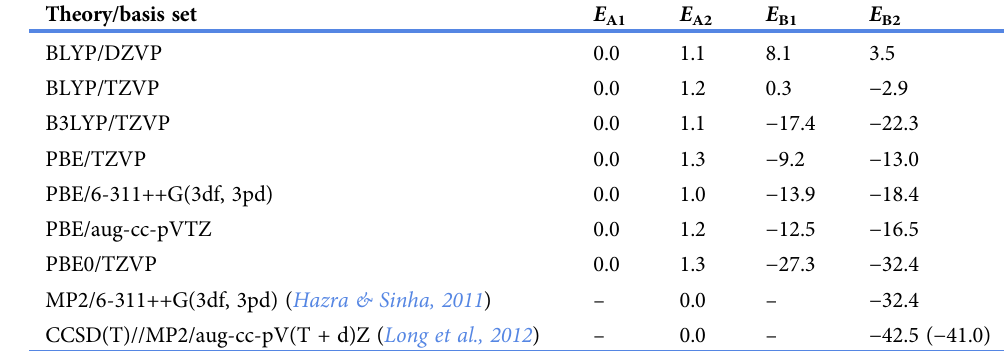
Table 1 Energetics of optimised reactant (A1 and A2) and product (B1 and B2) states using several different combinations of DFT functionals and basis sets. We also compare with high-level ab initio results already available in the literature ( Hazra & Sinha, 2011 ; Long et al., 2012 ). We note that the 6-311++G(3df, 3pd) Gaussian basis set is similar to the TZV2P plane-wave basis set. The zero of energy is de fi ned to be the lowest energy reactant state. All energies are expressed in units of kJ mol − 1 . Only the result of ( Long et al., 2012 ) includes zero point vibrational energy (ZPE) corrections (in brackets). Theory/basis